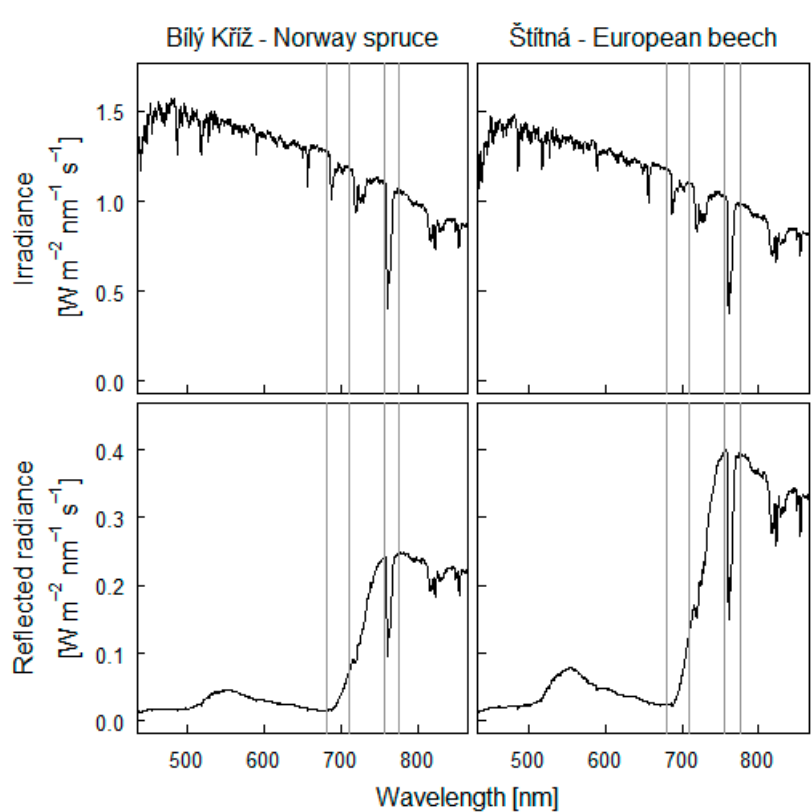
Figure 2. Spectra of irradiance and reflected radiance from the spruce ( Picea abies ) forest at the Bílý K ř íž station and from the beech ( Fagus sylvatica ) forest at the Štítná station measured at midday on a sunny day in summer. Grey vertical lines indicate the wavelengths used as reference for estimating fluorescence emissions in the O 2 A band and in the O 2 B band from the spectra.